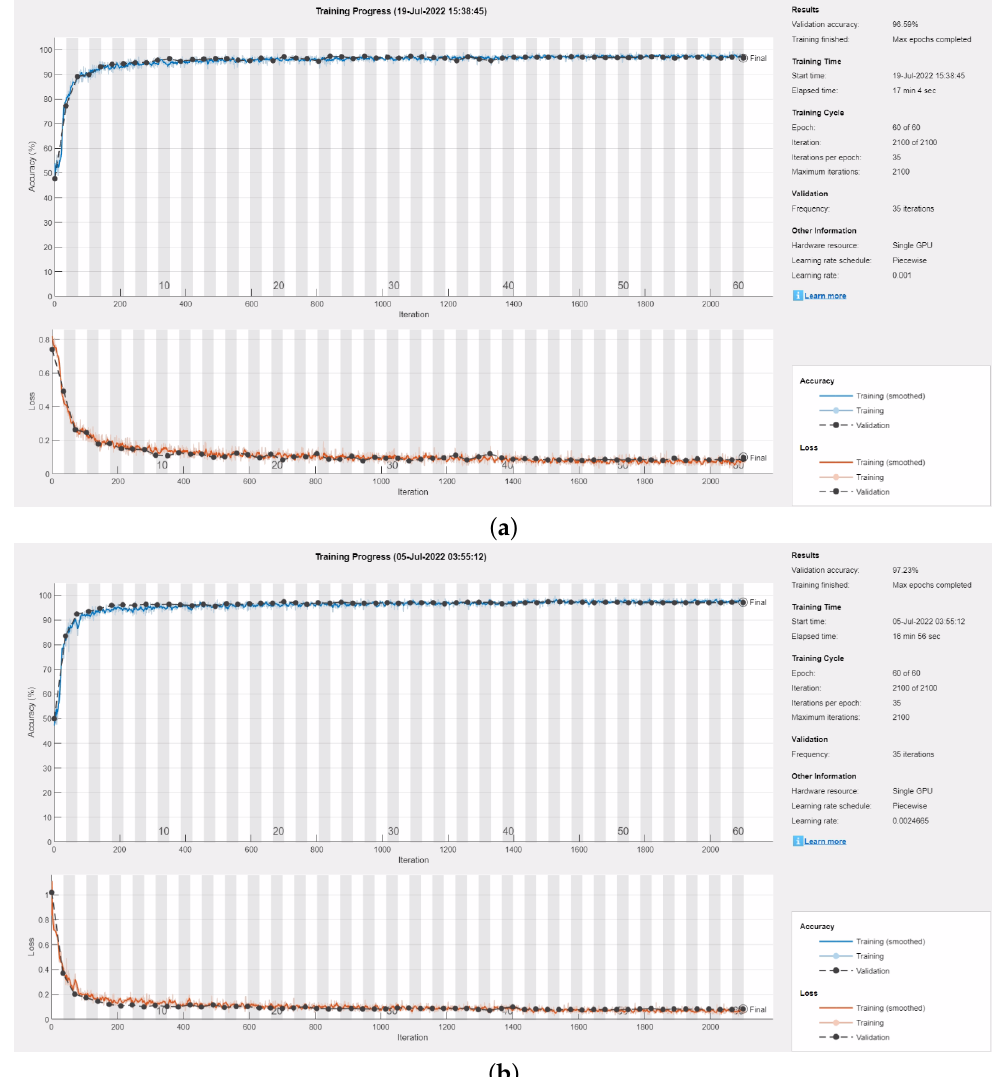
Figure 12. Training progress plot of the proposed CNN trained on the OCT dataset in Experiment 2: ( a ) NO-CNN; ( b ) optimal BO-CNN of iteration # 6.